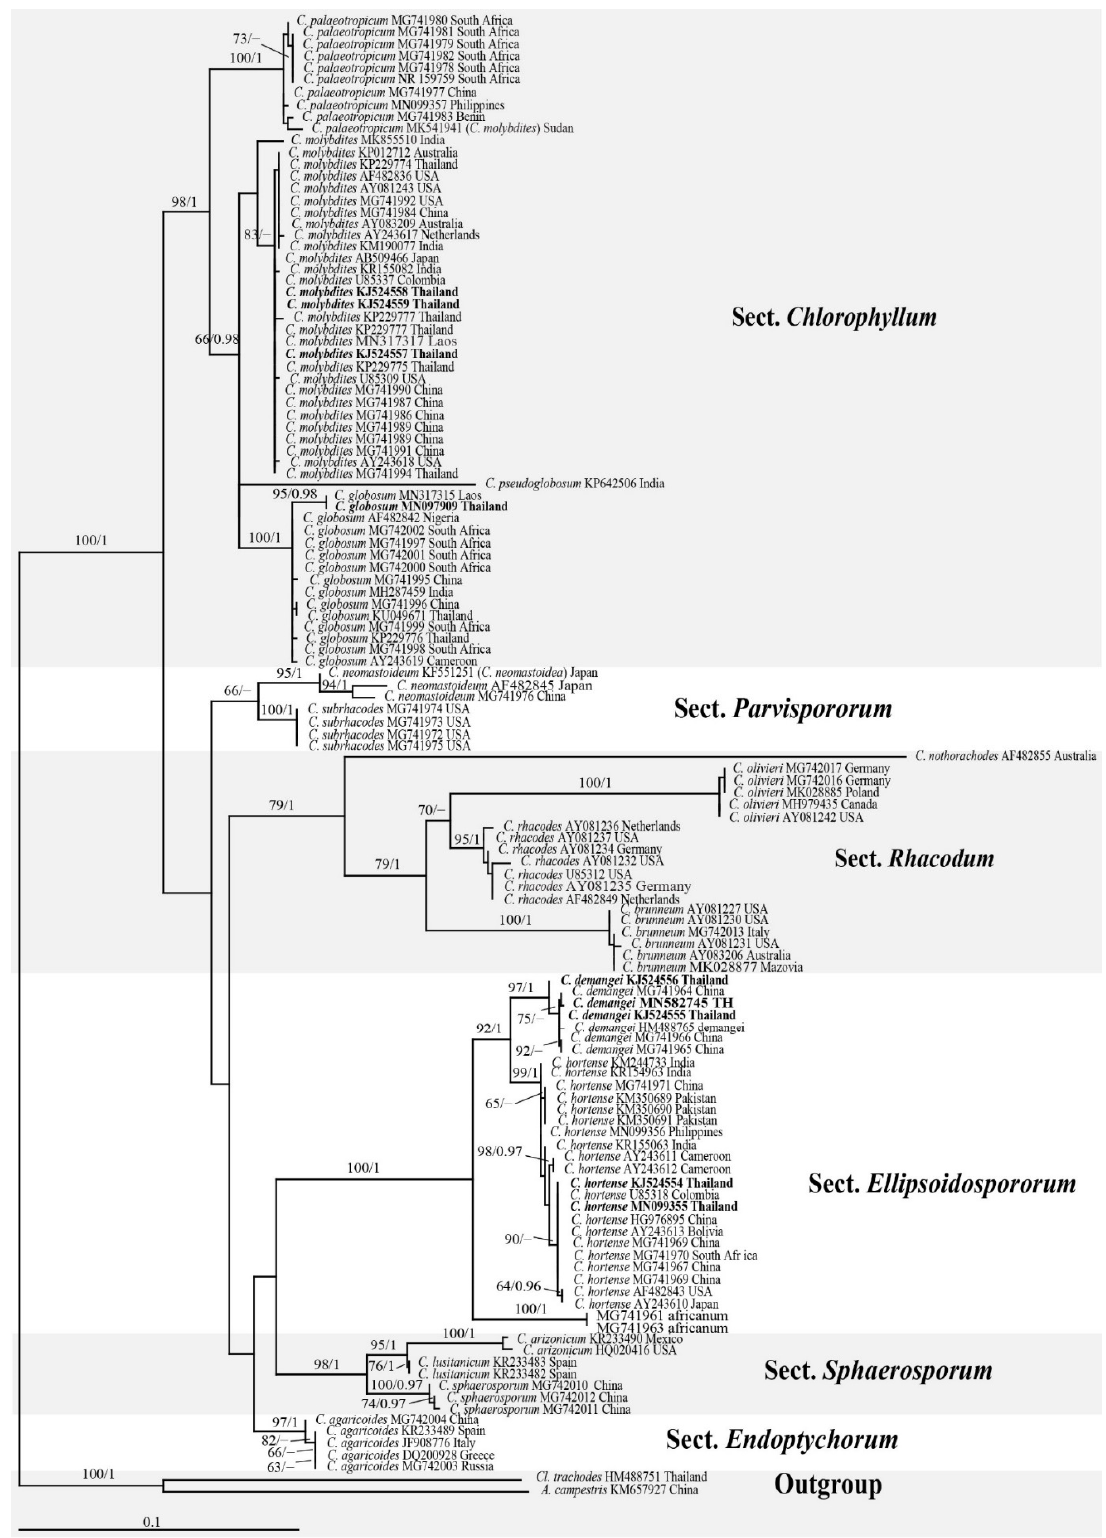
Figure 2. Maximum likelihood phylogenetic tree of Chlorophyllum based on nrITS sequences. New sequences generated from Thailand are in bold. Bootstrap values for maximum likelihood equal to or greater than ≥ 60 and Bayesian posterior probabilities ≥ 0.95 are placed above the branches. Genus abbreviations are as follows: A = Agaricus , C = Chlorophyllum , Cl = Clarkeinda , Thai specimens from this study are in bold types. Clarkeinda trachodes (Berk.) Singer and Agaricus campestris L. are outgroup. GenBank accession number and country are indicated after species name .